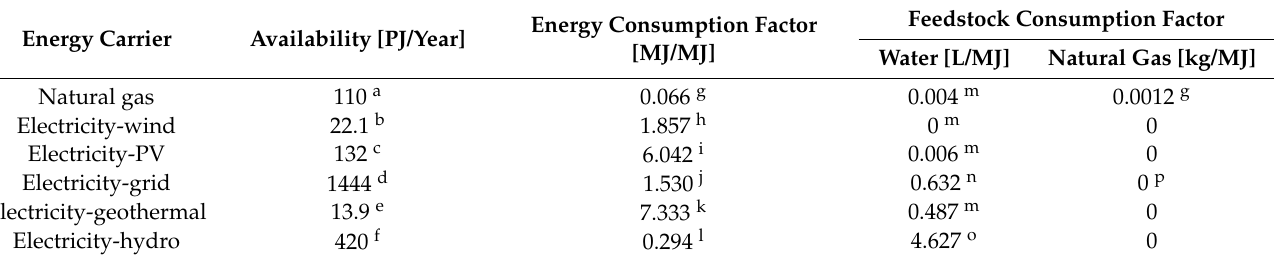
Table 4. Maximum amount of energy carrier available, energy consumption factors for energy carrier production and feedstock consumption factors for energy carrier